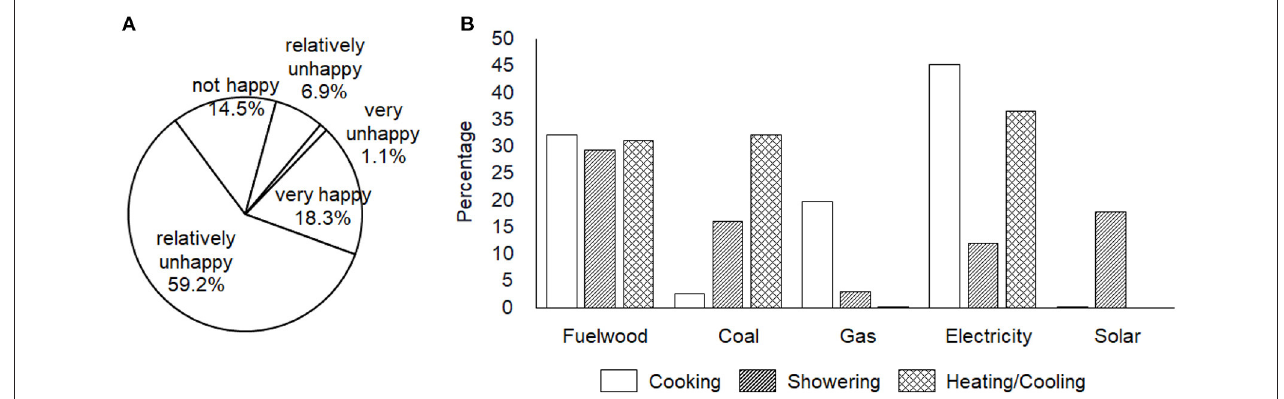
FIGURE 2 | The data distribution of happiness index (A) and energy consumption revolution (B) based on the China General Social Survey (CGSS) in